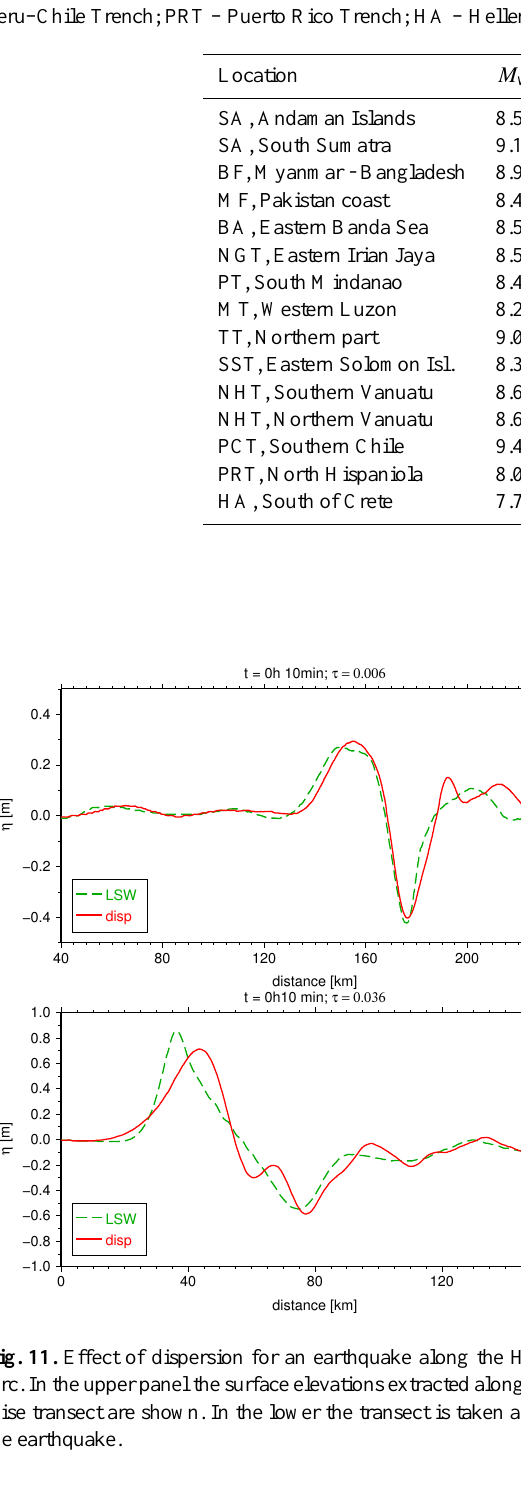
Table 2. Values for the dispersive parameter τ for a selection of sources applied in Løvholt et al. (2012a). τ is measured at a distance of 1000km away from the source. The earthquake source parameters: M w – magnitude; B – length; W – width; and D – dip angle. h is the average sea depth used for estimation of τ . Abbreviations: SA – Sunda Arc; BF – Burma Fault; MF – Makran Fault; BA – Banda Arc; NGT